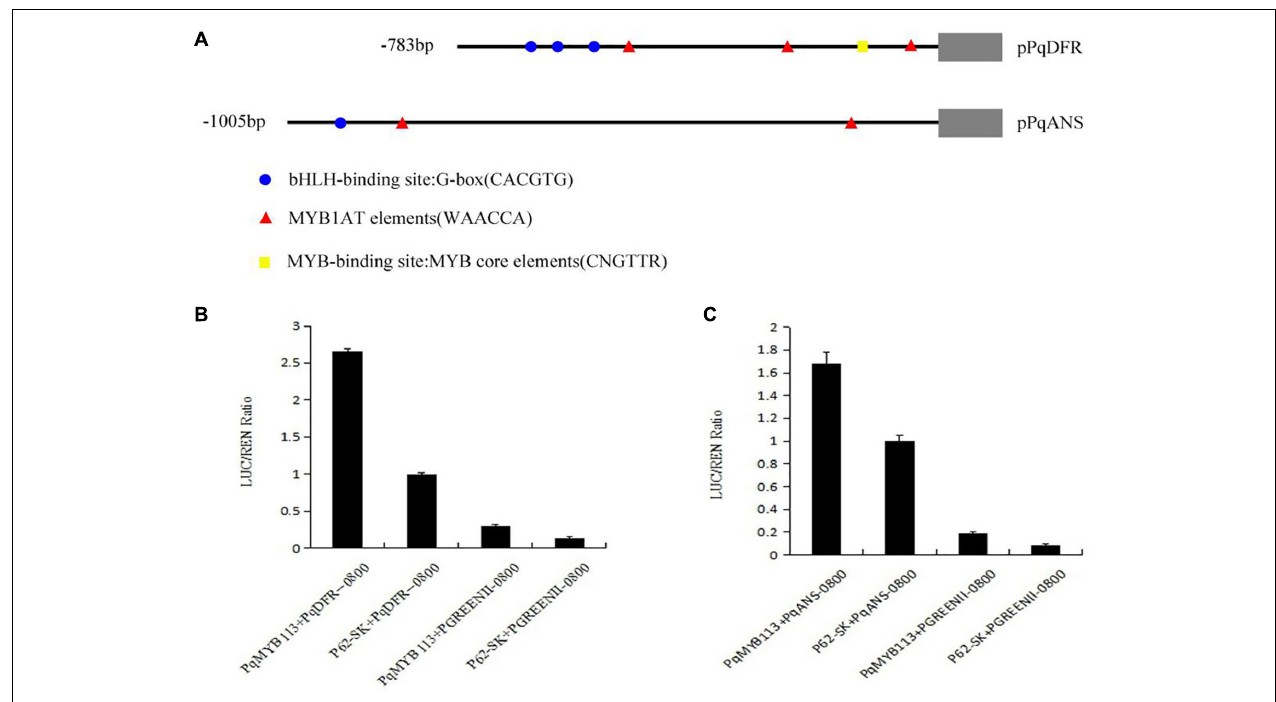
FIGURE 8 | Dual luciferase transient expression assay of PqDFR, PqANS promoters and PqMYB113. (A) The distribution of MYB binding and bHLH-binding elements in the promoter sequences of PqDFR and PqANS . (B) The effect of PqDFR promoter activity by PqMYB113. (C) The effect of PqANS promoter activity by PqMYB113. The ratio of LUC/REN of the empty vector (SK) plus promoter was used as calibrator (set as 1).